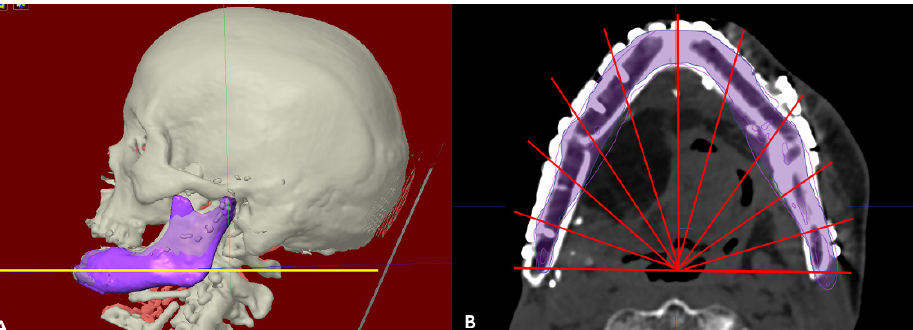
Figure 11. Evaluation of accuracy of reconstruction with virtual plan. ( A ) Reconstructed mandible superimposed over virtual plan, a section through the mid-way of chin and parallel to the lower mandibular border selected for measurement (yellow line). ( B ) The length of reconstruction divided into ten segments by eleven red lines, eighteen degrees each from center of angle-angle baseline and discrepancy measured at eleven points at the outer border (excluding the reconstruction plate).